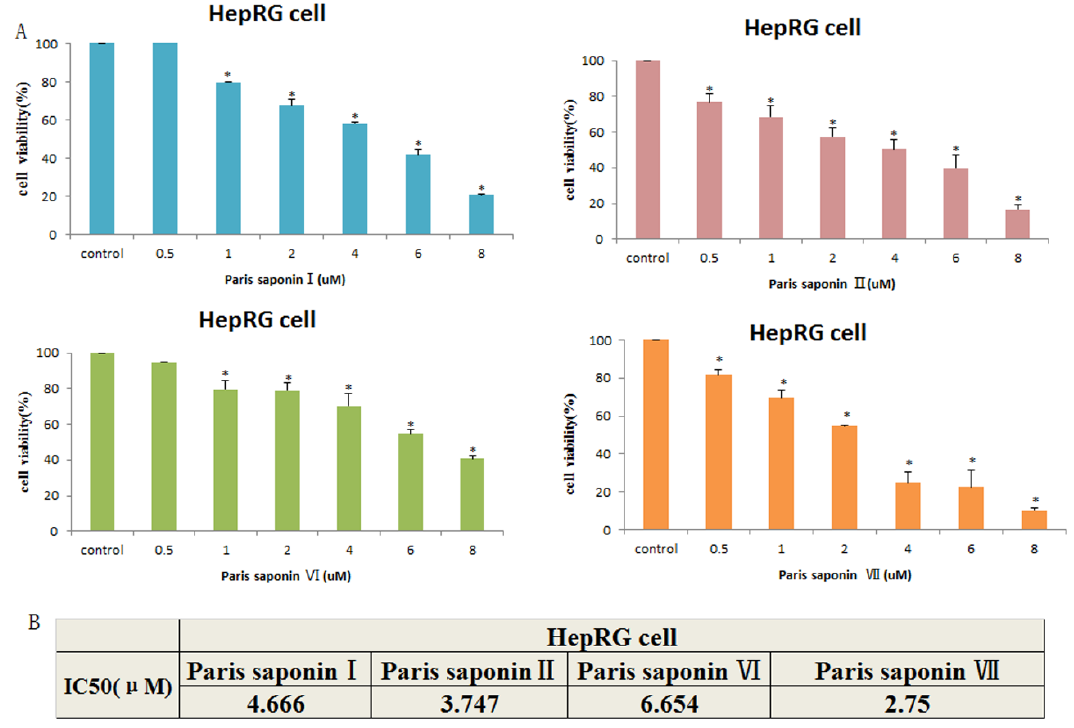
Figure 3. Cytotoxic e ff ects of the four saponins on HepaRG cells. ( A ) Cell viability of HepaRG cells as measured with an MTT assay. Data are presented as mean ± SD. * p < 0.05, compared with the vehicle-treated group. ( B ) The cell viability data of HepaRG cells treated with four saponins for 24 h were analyzed with the SPSS17 software, and the IC 50 values were obtained.